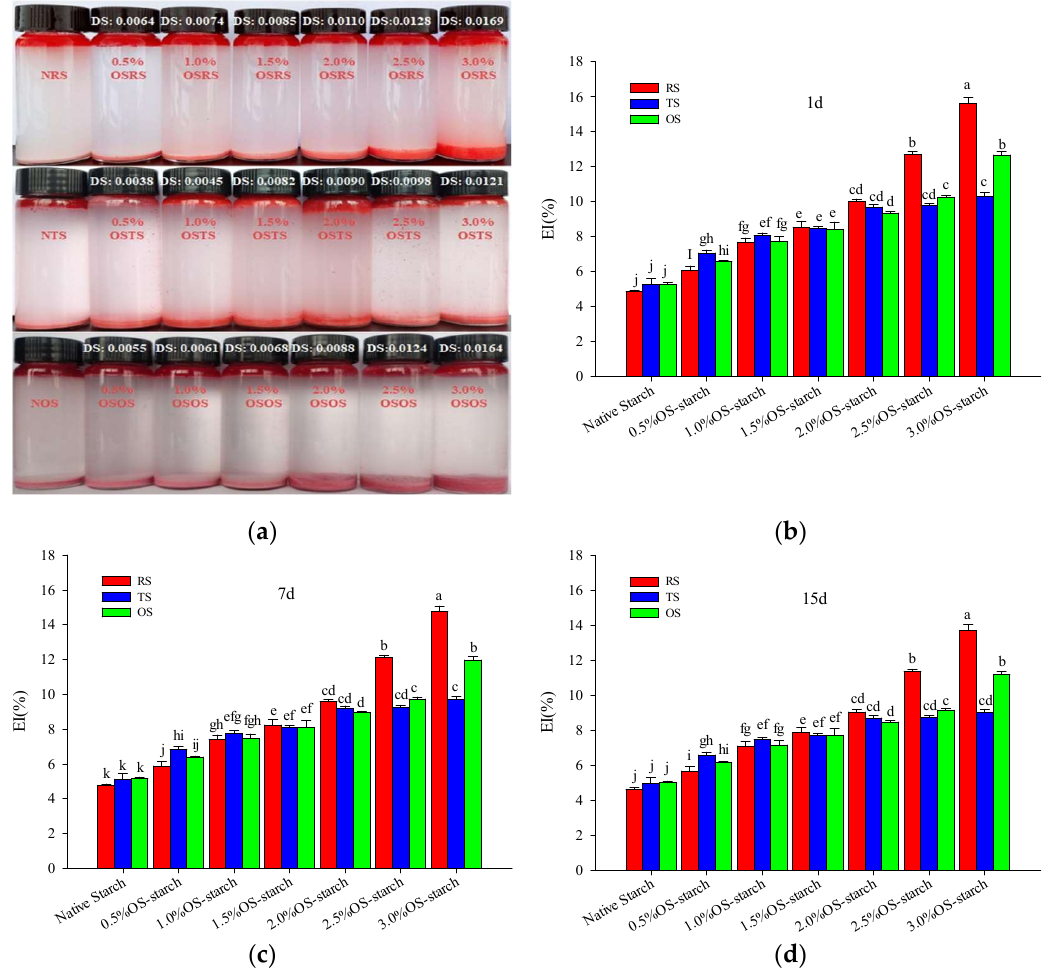
Figure 7. Pickering emulsions prepared from the native starch and OS-starch ( a ), and the EI values of the emulsions standed for 1 d, 7 d and 15 d ( b – d ). Note: The data means average value ( n = 3); the different letters (a–j) means differ significantly ( p < 0.05), the same indicates that the difference is not significant ( p > 0.05).